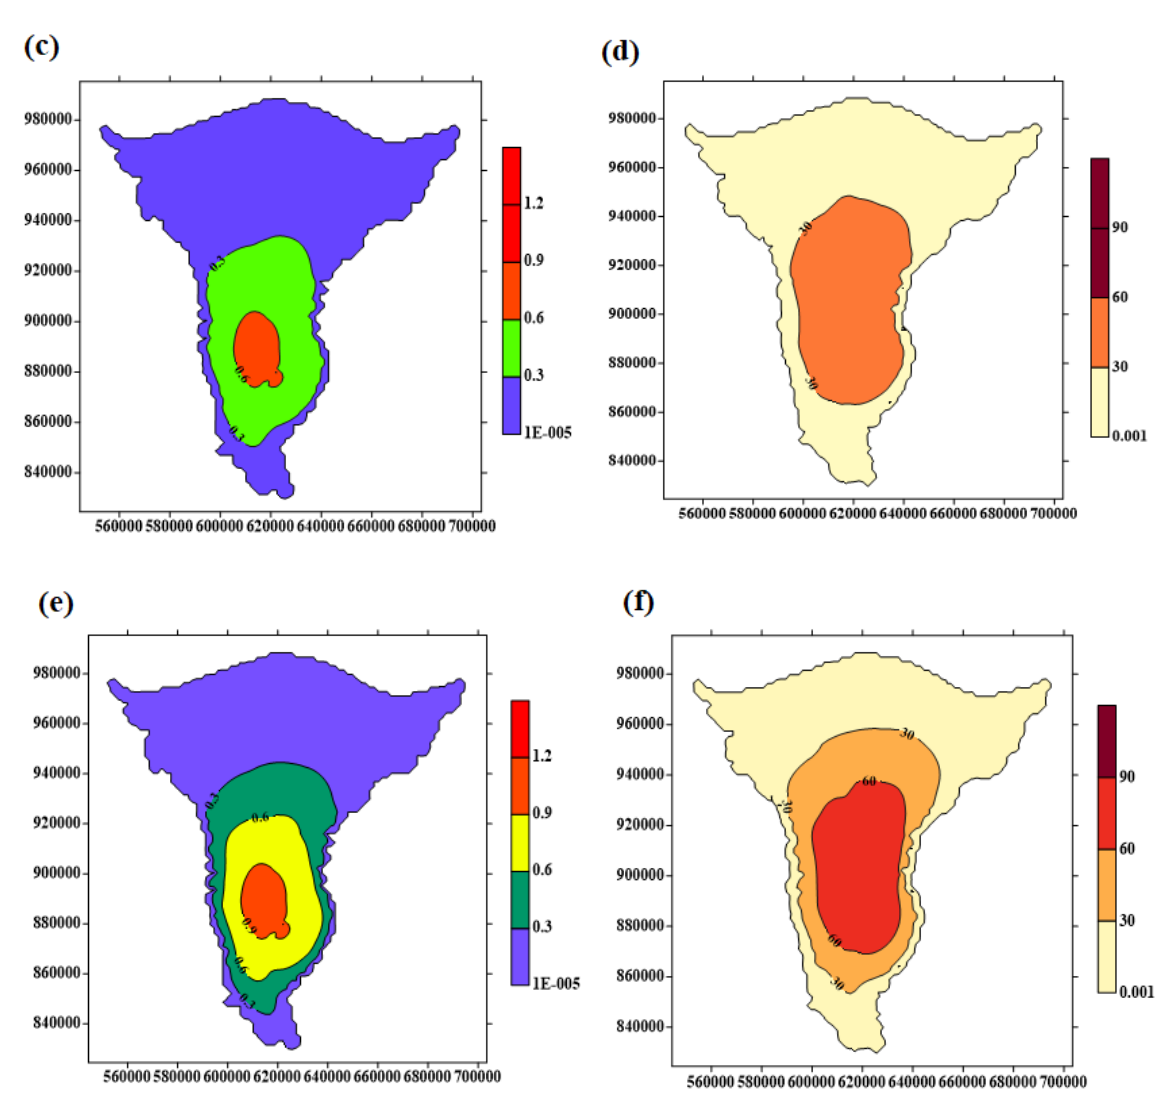
Figure 8. Results of drawdown in (m) and Land subsidence in (mm) in the MND due to decreasing recharge. ( a ) GW drawdown during 2010 to 2030, ( b ) LS during 2010 to 2030, ( c ) GW drawdown during 2010 to 2050, ( d ) LS during 2010 to 2050, ( e ) GW drawdown during 2010 to 2070 ( f ) LS during 2010 to 2070.